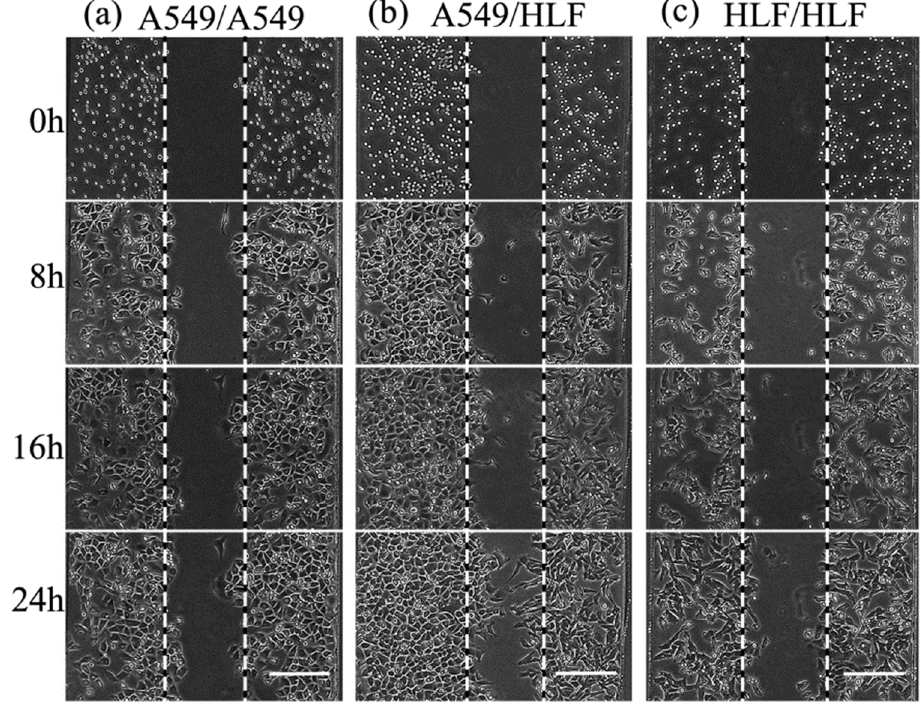
Figure 5. Contrast images of cells migrating on the micro-fluidic device at different times for different groups. ( a ) A549–A549. ( b ) HLF–A549. ( c ) HLF–HLF. Scale bar = 200 µ m.